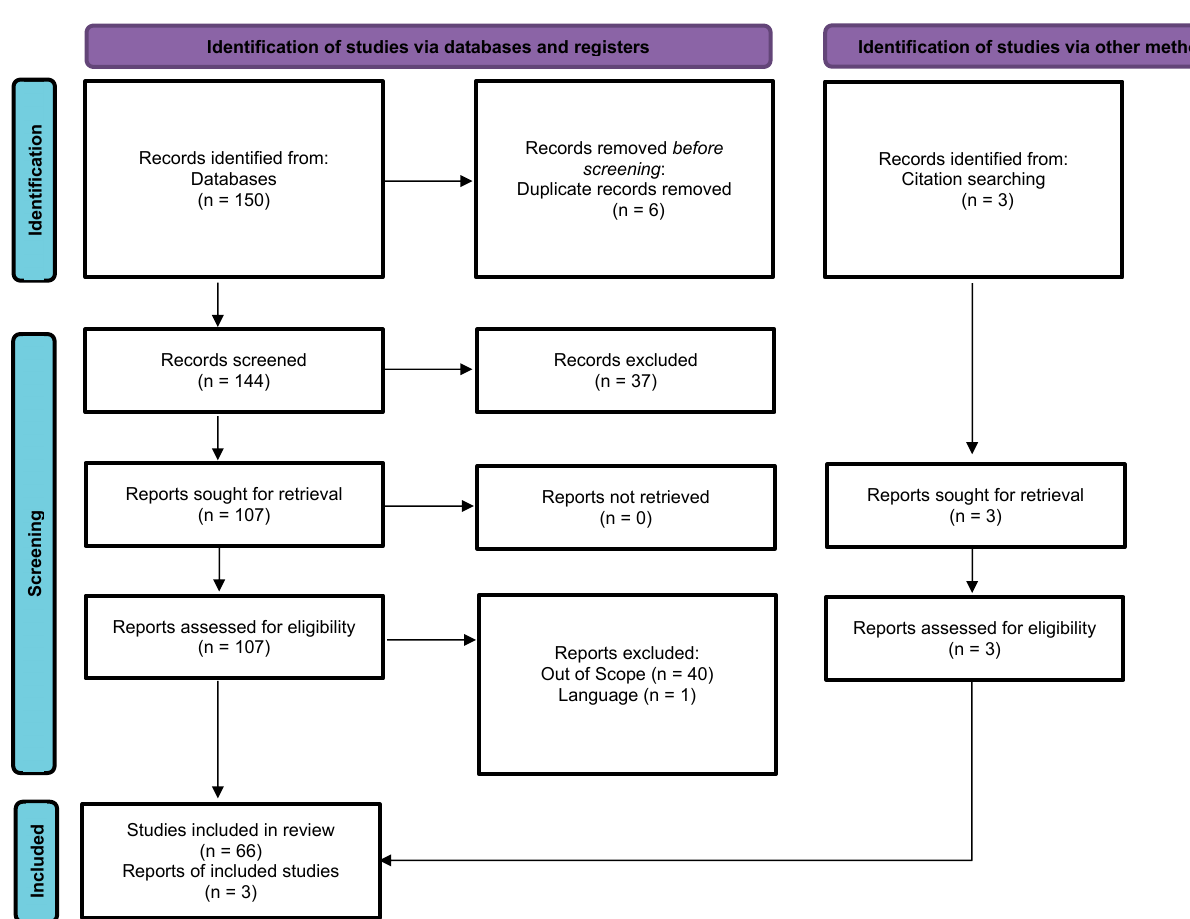
Figure 1. PRISMA flow diagram of included studies, adapted from Ref.